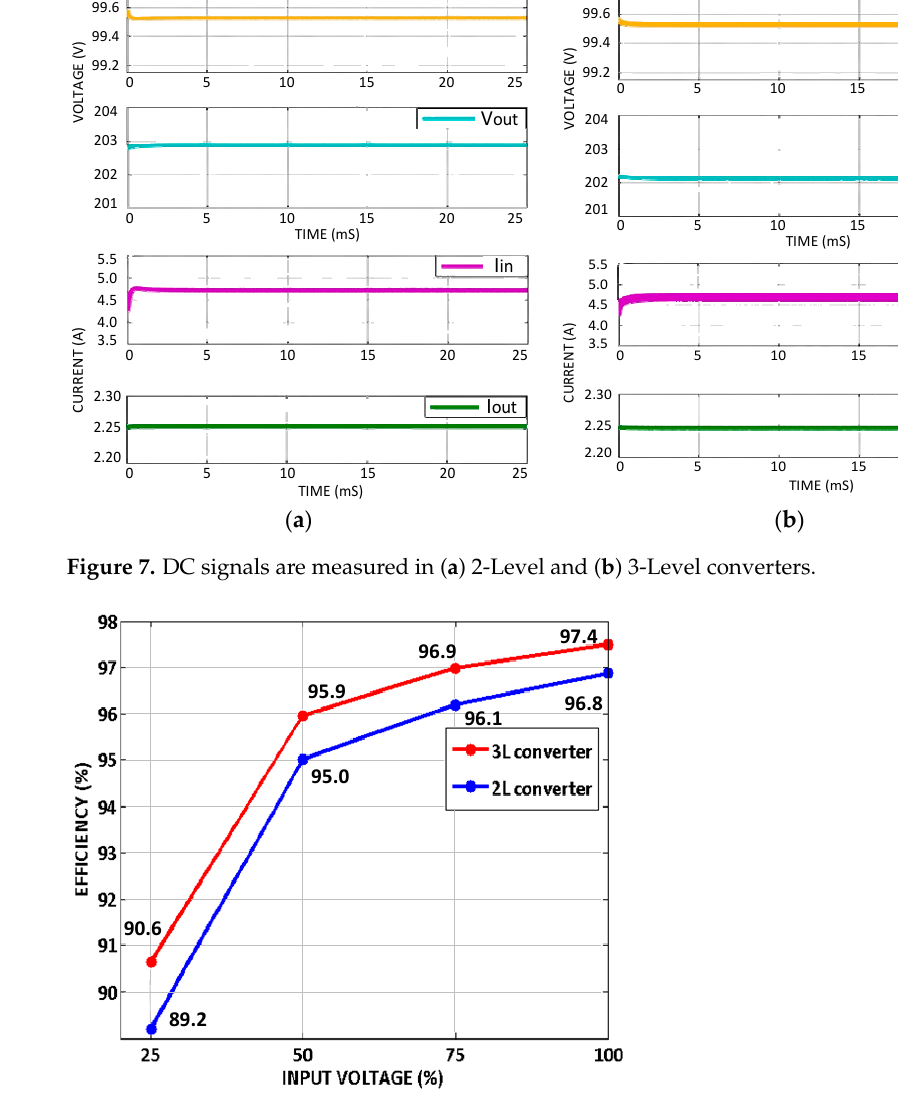
Figure 8. Converter efficiency from simulation measurements.